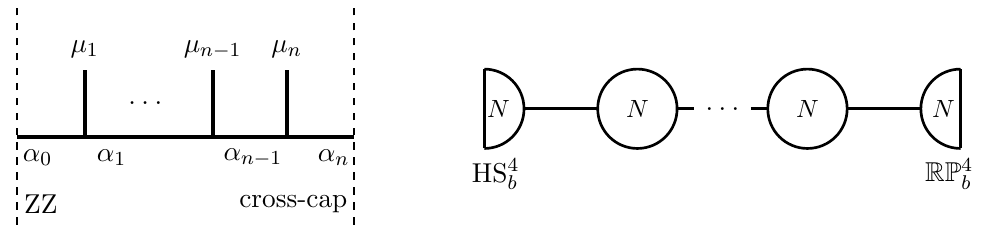
Figure 4 . Left: conformal block of the g = su ( N ) W-algebra for the n -point function on a M(cid:127)obius strip, with semi-degenerate external momenta (cid:22) i = (cid:20) i ! 1 (this keeps fusion multiplicities (cid:12)nite). Right: corresponding quiver, built from SU( N ) vector multiplets and bifundamental hypermulti- plets de(cid:12)ned on S 4 . The leftmost and rightmost vector multiplets are subject to Z 2 identi(cid:12)cations b turning them e(cid:11)ectively into (cid:12)elds on HS 4 (with Neumann boundary conditions) and RP 4 respec- b b tively. The momenta (cid:11) i are Coulomb branch parameters of the corresponding gauge groups,